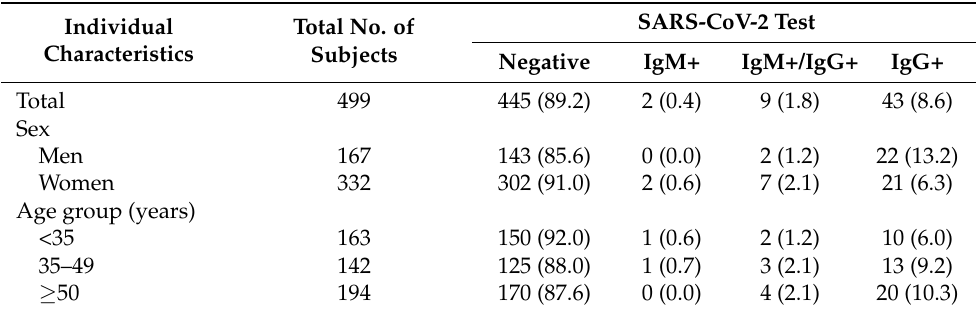
Table 1. Distribution of 499 workers in dental centers from Lombardy region, Italy, by SARS-CoV-2 positivity, overall and by sex and age. Lombardy 2020.